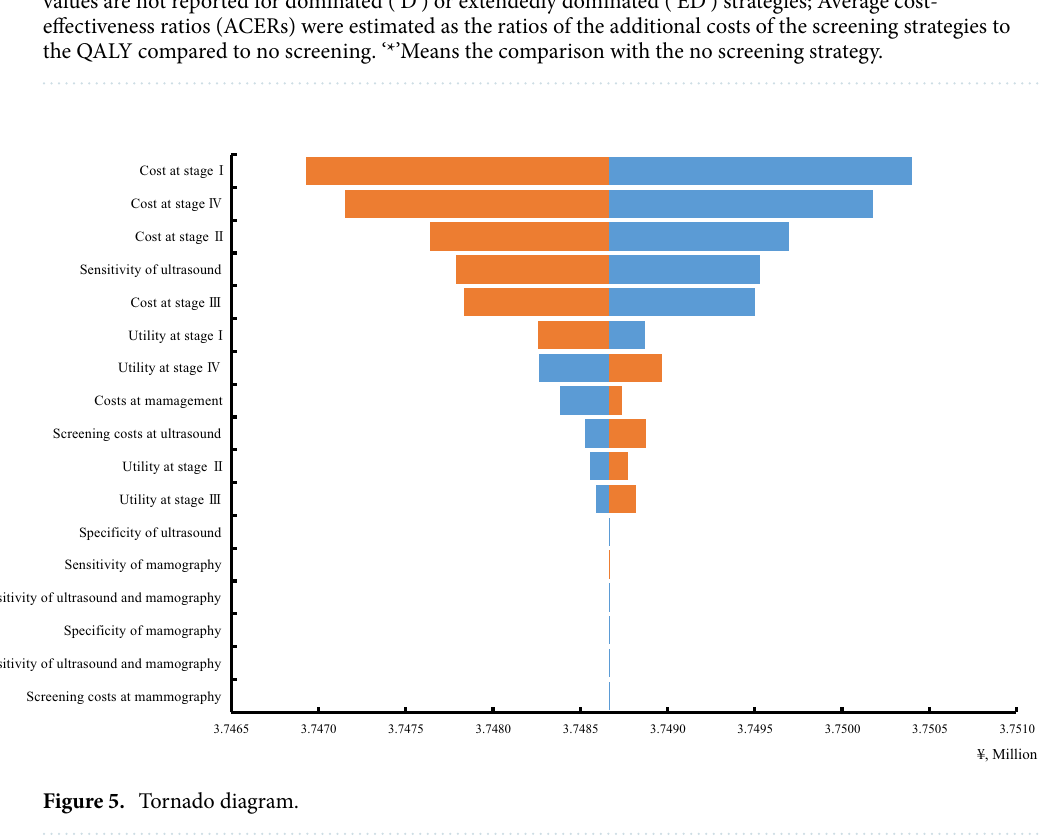
Figure 5. Tornado